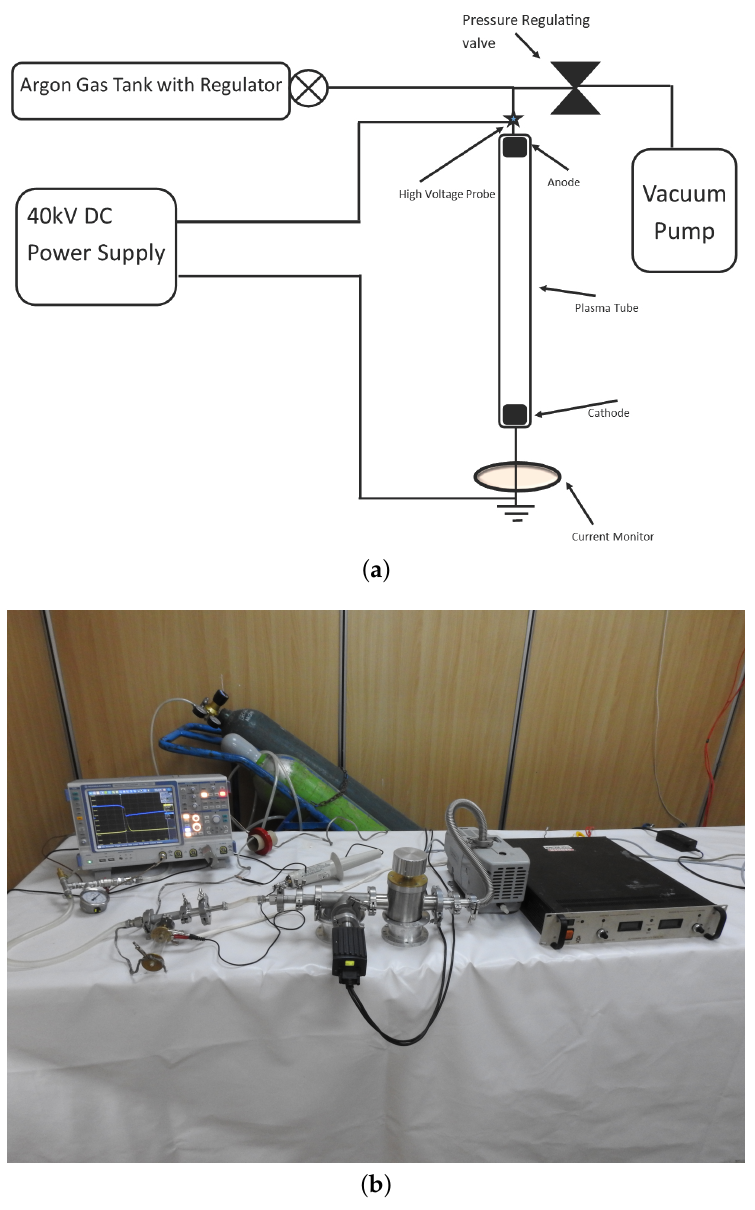
Figure 8. ( a ) Schematic of experimental setup; ( b ) experimental setup with vacuum pump, argon tank, pressure gauge, and high voltage DC power supply connected to a plasma